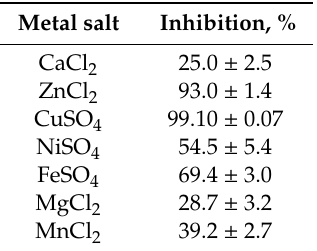
Table 2. E ff ect of metals on BlpLc activity. Table 2. Effect of metals on BlpLc activity.